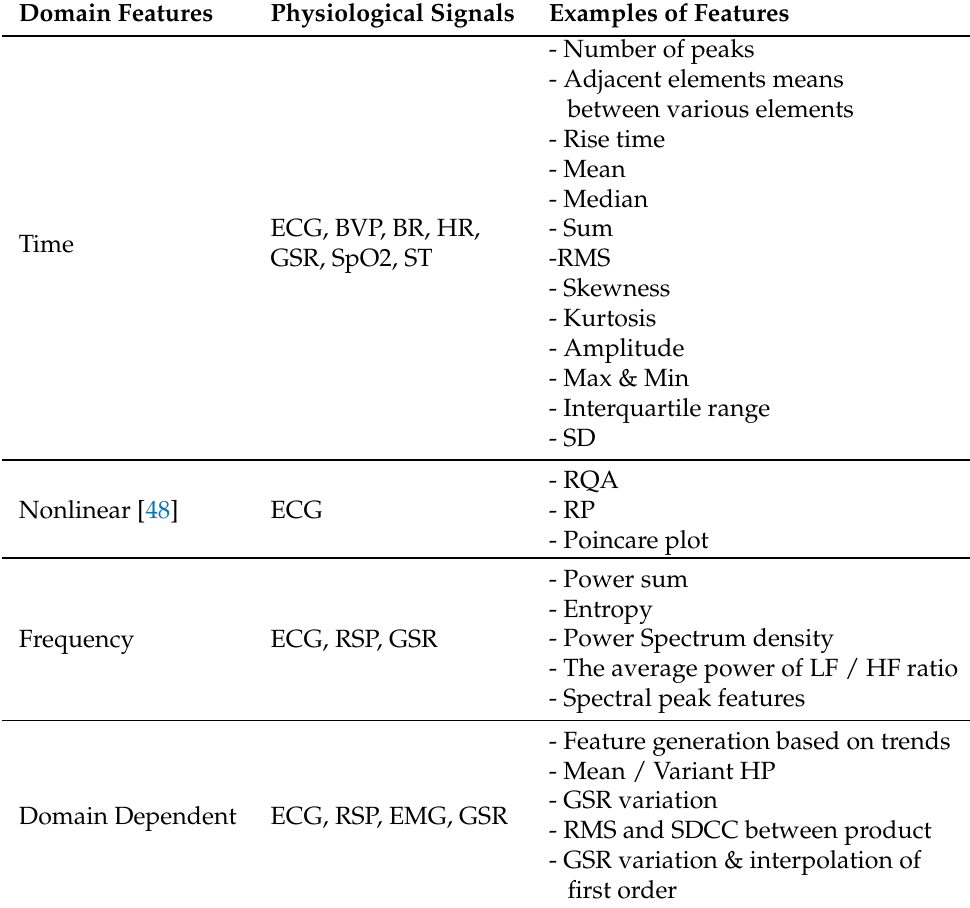
Table 1. State-of-the-art for feature types in stress recognition using physiological signals. Domain